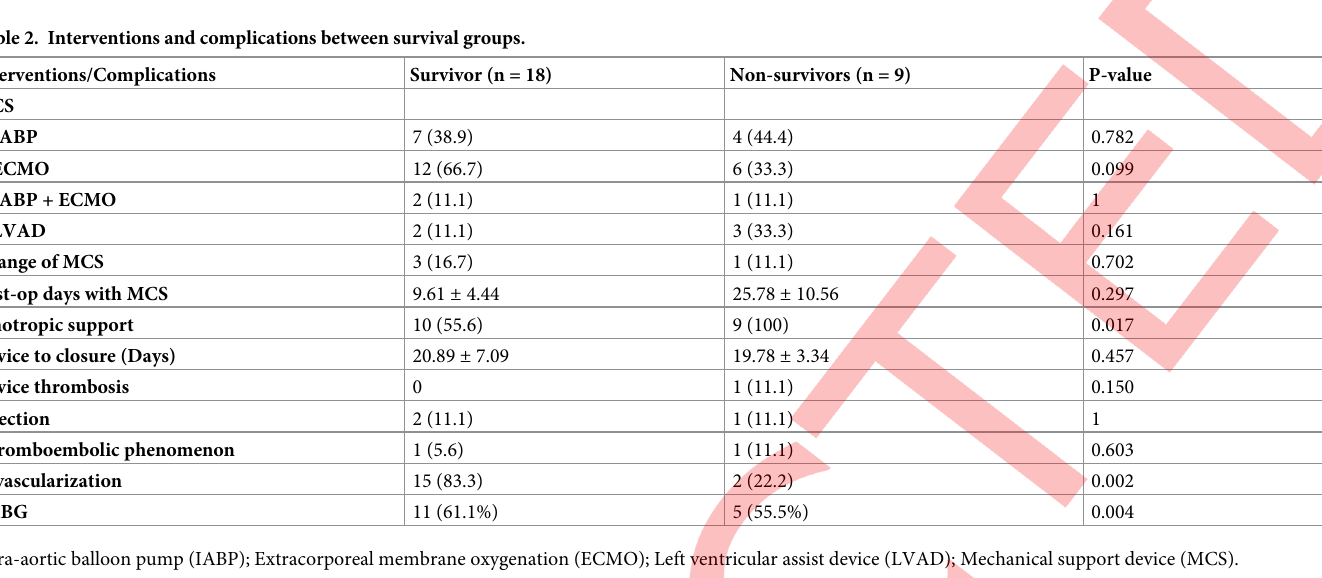
All operations were performed via median sternotomy. Aortic cross clamping and cold car- dioplegic liquid was applied for myocardial protection after initiation of hypothermic cardio- pulmonary bypass. Single patch closure with Dacron pericardial patch or bovine pericardial